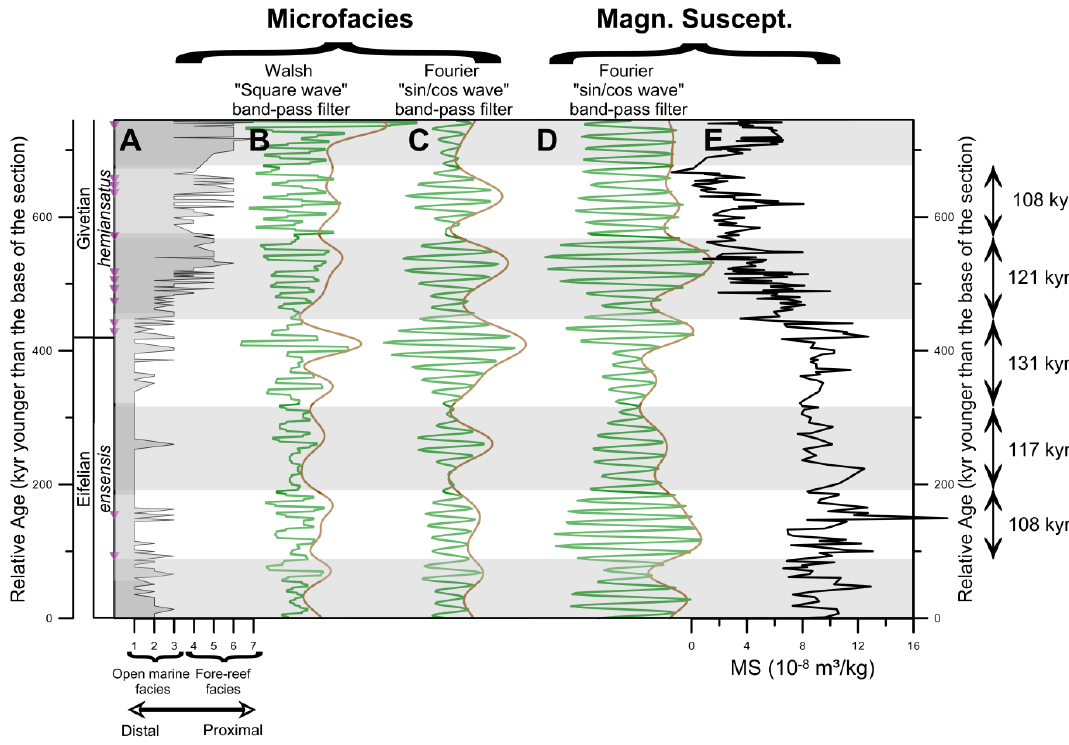
Fig. 6. (A) : microfacies series of the “La Couvinoise” section plotted against a time-axis. (B) : band-pass filtered microfacies signal at the frequency of precession (filtered between 15 and 23 kyr; green) based on the Walsh Transform+amplitude envelope (brown). (C) : band-pass filtered microfacies signal at the frequency of precession (15–23kyr; green) based on the Fourier Transform+amplitude envelope (brown). (D) : band-pass filtered MS signal at the frequency of precession (15–23kyr; green) based on the Fourier Transform+amplitude envelope (brown). (E) : MS signal of the “La Couvinoise” section plotted against a time-axis. Purple triangles indicate those precessional cycles within which the half-precessional cycles are well developed.